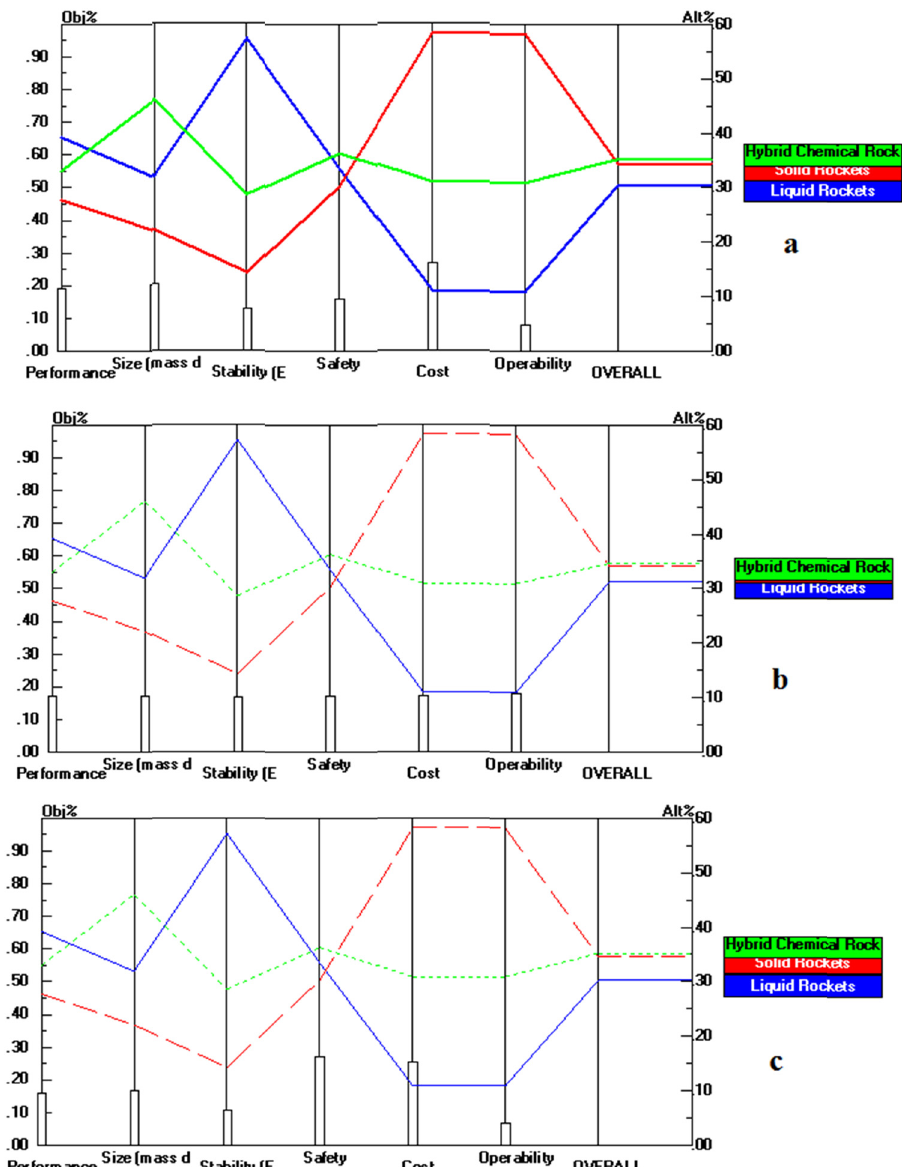
Figure 8: Sensitivity analysis after changing the